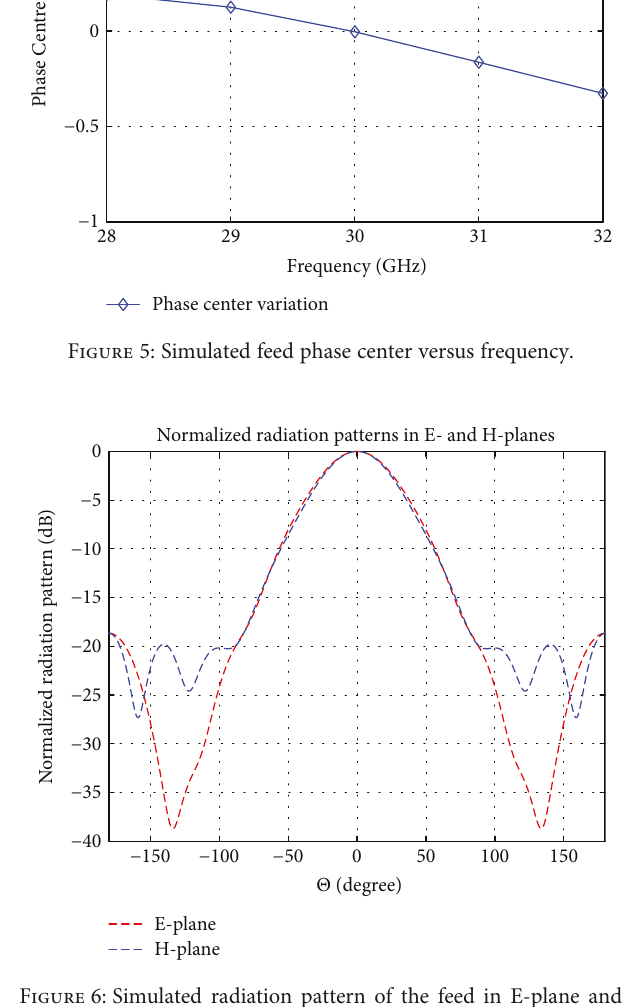
Figure 6: Simulated radiation pattern of the feed in E-plane and H-plane at 30